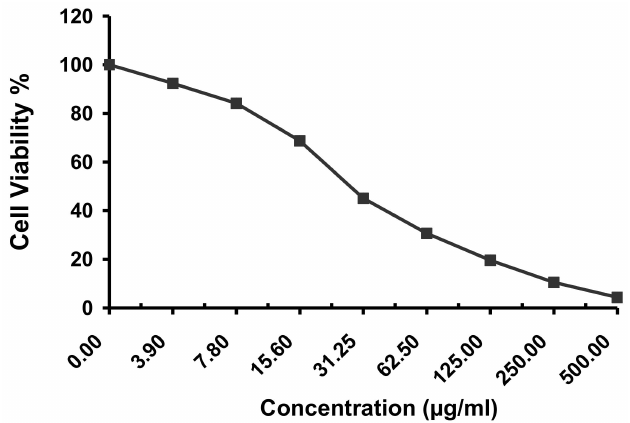
Figure 14. HCT-116 of dye 30h . Figures 11–14 reveal that dye 30h had high activity, with values of 62.2 ( ± 4.1) (MCF-7), 23.4 ( ± 1.2) (HepG-2), 53.6 ( ± 5.8) (A-549), and 28 ( ± 1.9) (HCT-116), indicating that the related molecule has promising anticancer